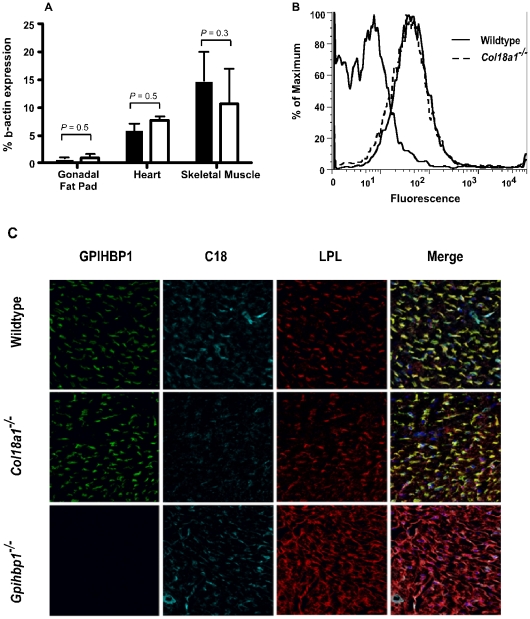
Normal vascular distribution of Gpihbp1 in Col18a1
−/− mice.(A) mRNA expression was determined in RNA samples isolated from gonadal fat pad, heart and soleus muscle from wild-type and Col18a1
−/− mice (n = 4, for each strain). Results were verified in two independent assays. (B) Primary cardiac endothelial cells were isolated from control (solid line) and Col18a1
−/− mice (dashed line) by collagenase digestion and magnetic beads separations using anti-CD31 antibodies. Gpihbp1 was detected with a specific polyclonal antibody and Alexa-488 labeled anti-rabbit secondary antibodies followed by FACS analysis. The curve to the left represents cells incubated with a control IgG and secondary antibodies. Data are representative of 3 separate experiments. (C) Cardiac tissue sections from wild-type, Col18a1
−/− and Gpihbp1
−/− mice were analyzed by confocal microscopy and compared for differences in the distributions of Lpl (red), Col18 (blue) and the Gpihbp1 (green). The distributions of Lpl and Gpihbp1 overlap with Col18 staining in wild-type heart tissues and are not altered in the Col18a1
−/− mutant. The patterns of Lpl and Gpihbp1 staining were unaffected in skeletal muscle and fat (data not shown).